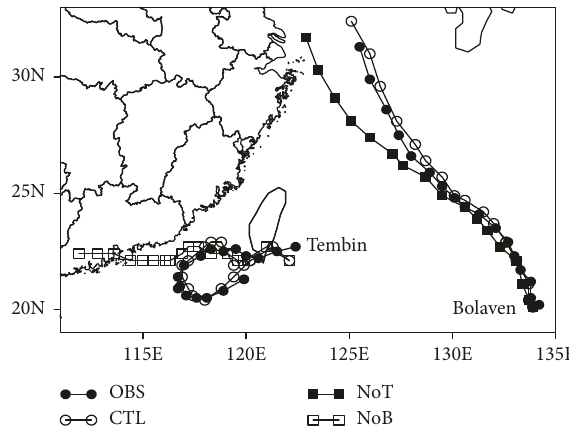
Figure 3: Tracks of Tembin and Bolaven from 1200 UTC 23 August to 1200 UTC 27 August (interval: 6 hours; black circle track: JTWC best track; white circle track: CTL experiment; black square track: NoT experiment; white square track: NoB